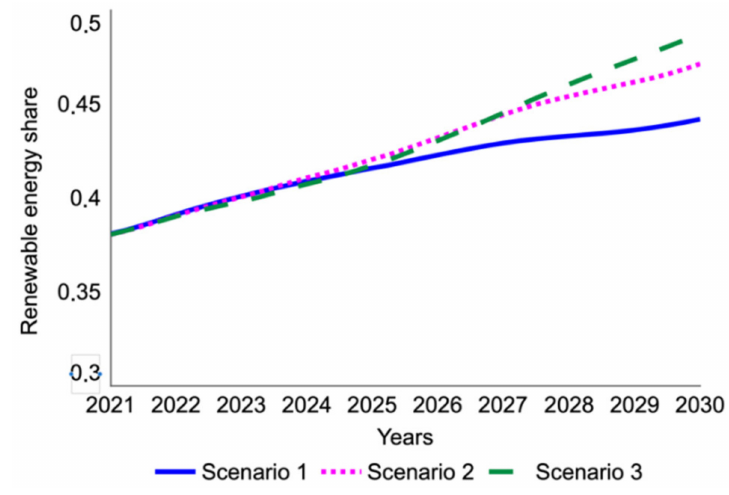
Figure 7. Renewable energy share for three policy scenarios. The cumulative costs by 2030 are EUR 0.5 billion for Scenario 1, EUR 2.8 billion, and EUR 7.6 billion for Scenario 3 (see Figure 8).